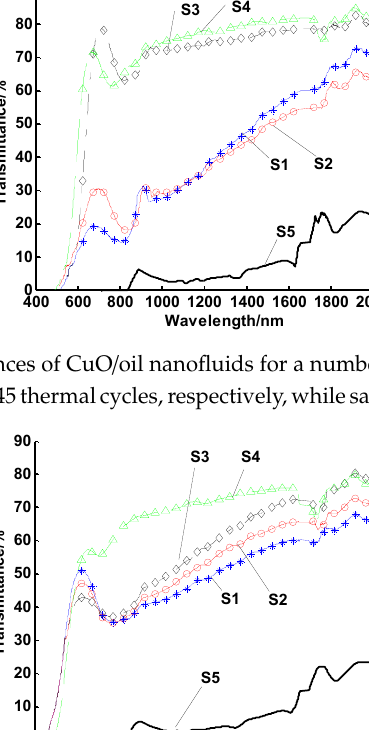
Figure 5. Spectral transmittances of CuO/oil nanofluids at different maximum temperatures. Note: samples 1–4 were tested at the maximum test temperatures of 80, 100, 120, and 150 °C, respectively, while sample 5 was kept at room temperature.